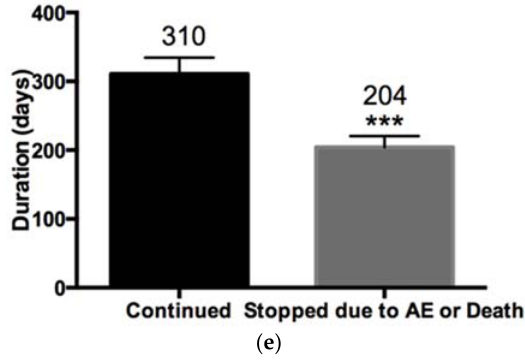
Figure 3. Impact of age, BMI, FVC, DLCO and duration of treatment on discontinuations due to AEs (Where *** denotes p < 0.001)